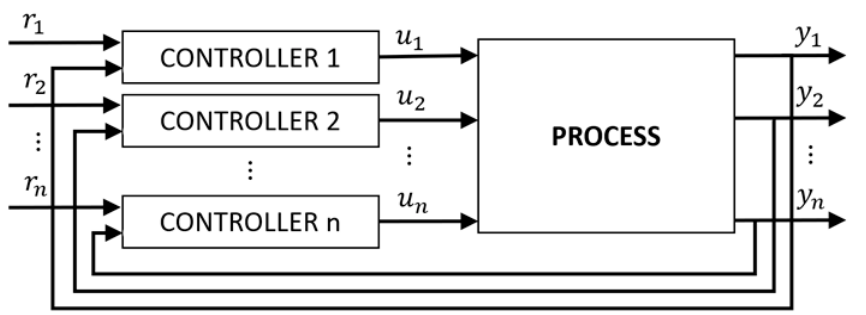
Figure 1. Multiloop control scheme.